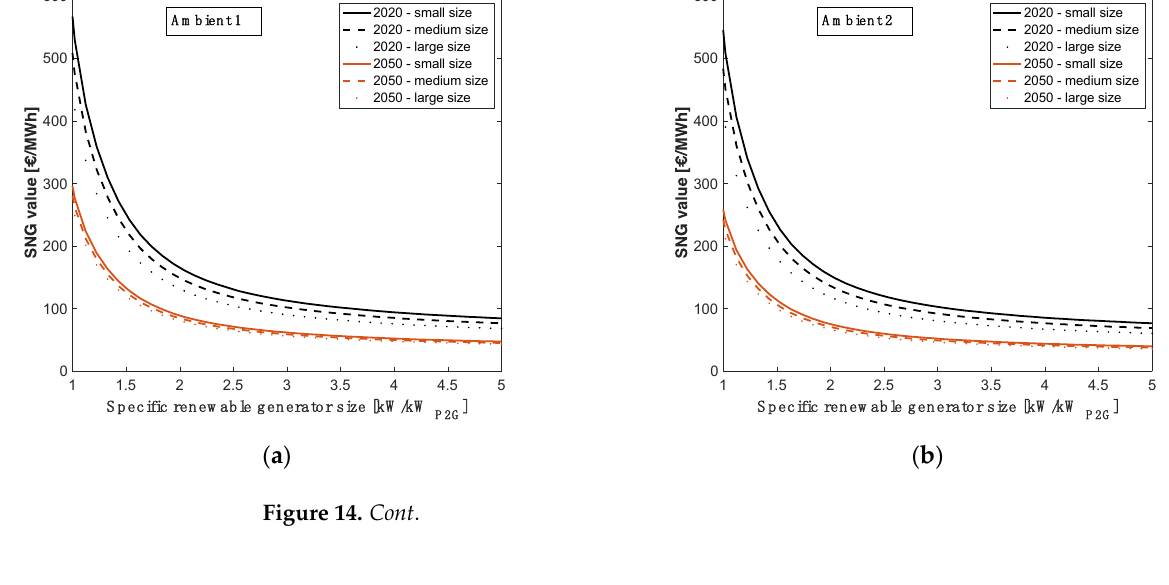
( d ) Figure 14. SNG value as a function of the SOEC cost development and of the renewable generator size for the several P2G thermodynamic configurations: ( a ) Ambient 1; ( b ) Ambient 2; ( c ) Pressur- ized 1; and ( d ) Pressurized 2.